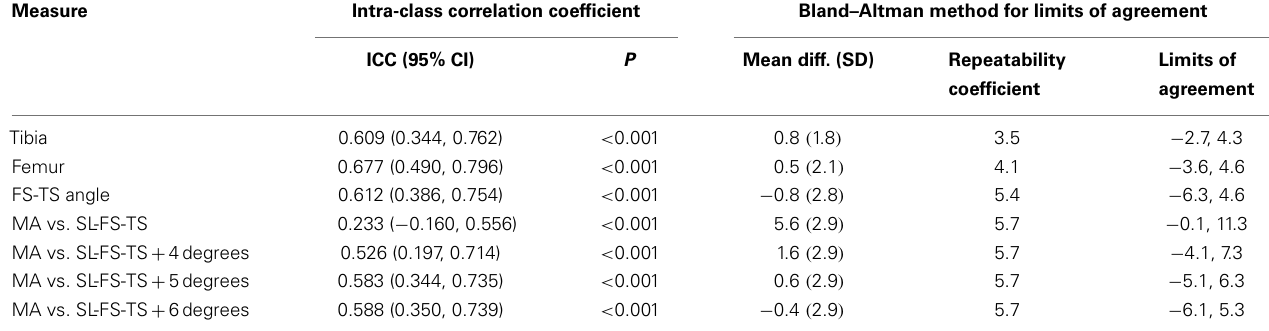
Table 1 | Correlations – short- vs. long-leg X-rays . Measure Intra-class correlation